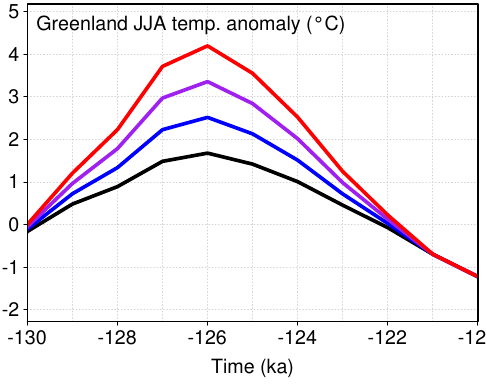
Fig. 2. Summer temperature anomalies during the Eemian for the applied paleo modification factors of 1 (black), 1.5 (blue), 2 (purple) and 2.5 (red).